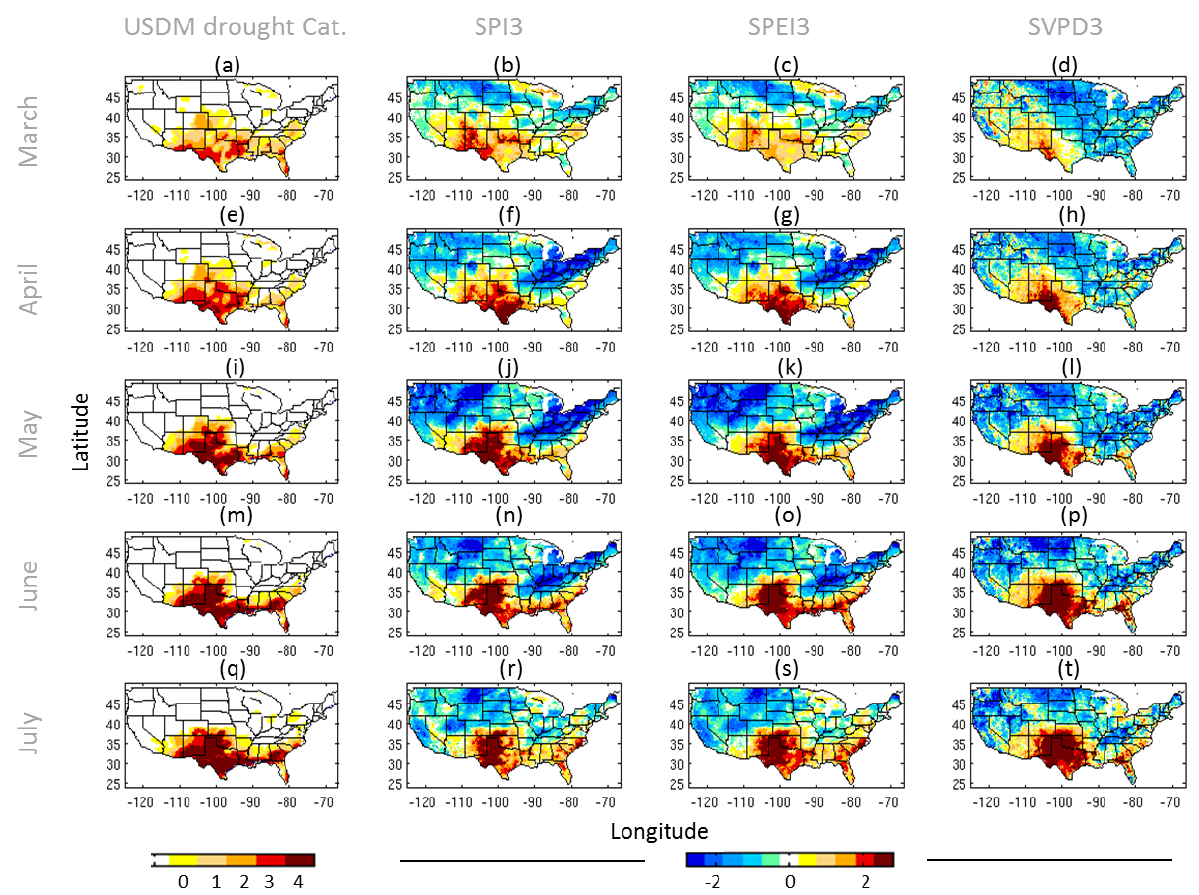
Figure 3. Development of 2011 Texas drought based on USDM, SPI3, SPEI3, and SVPD3 plotted from left to right, respectively. From top to bottom the maps correspond to ( a – d ) March, ( e – h ) April, ( i – l ) May, ( m – p ) June, and ( q – t ) July of 2011. For SPI3 and SPEI3 the signs are flipped to facilitate the